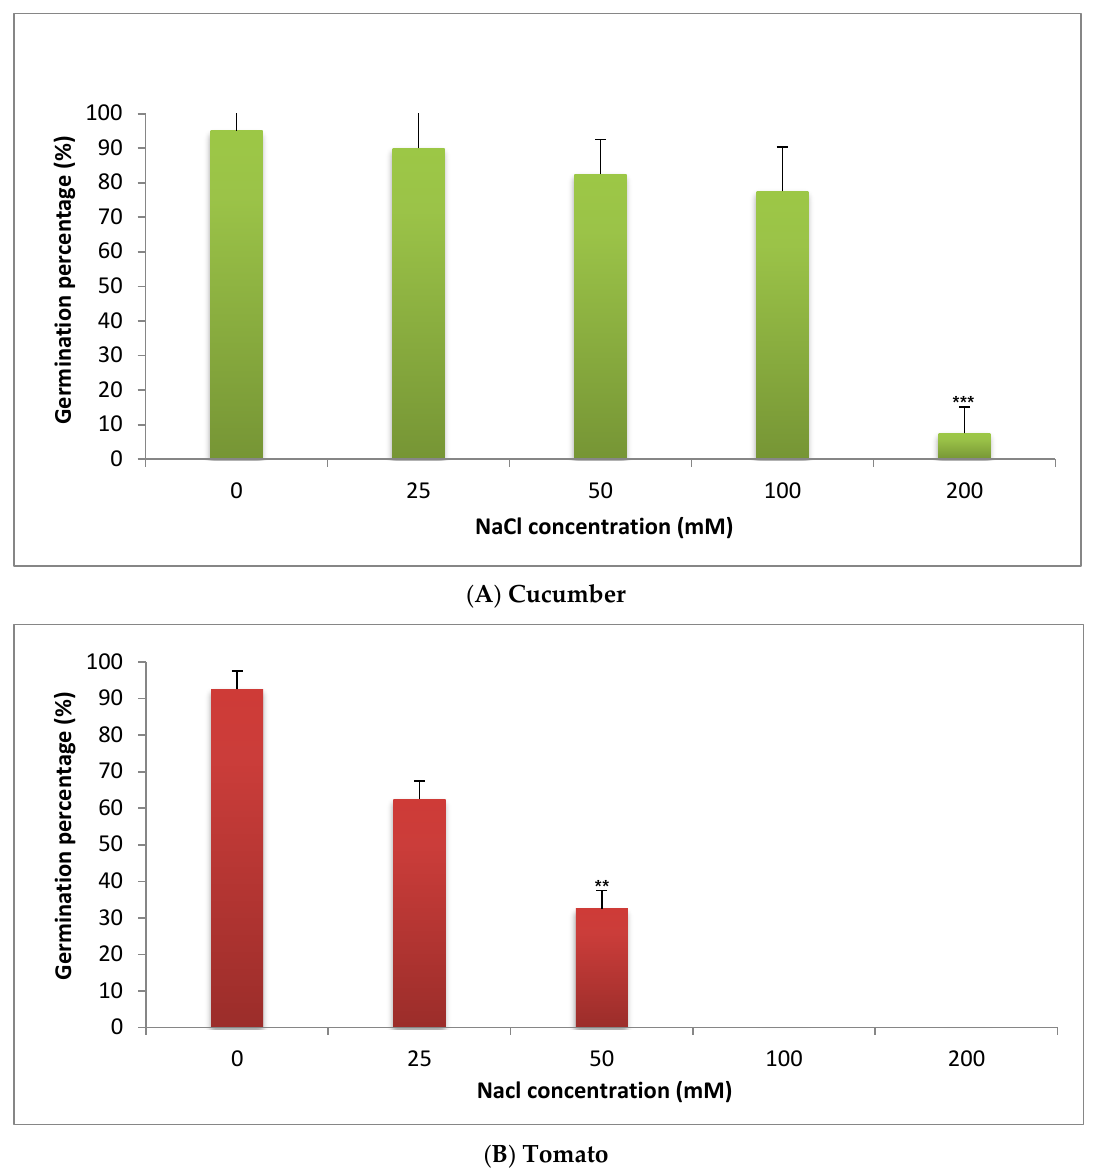
Figure 2. Effect of salinity stress on the percentage of seeds germination in cucumber ( A ) and in tomato ( B ) . ** = highly significant and *** = very highly